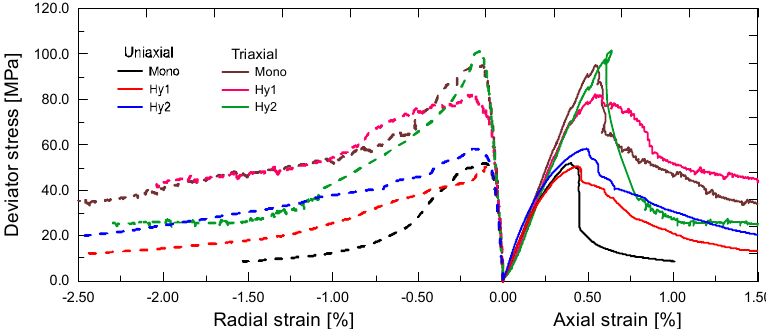
Figure 7. Comparison of typical stress–strain relations of engineered cementitious composites (ECC) mixtures with different steel fiber content under both uniaxial and triaxial compression.